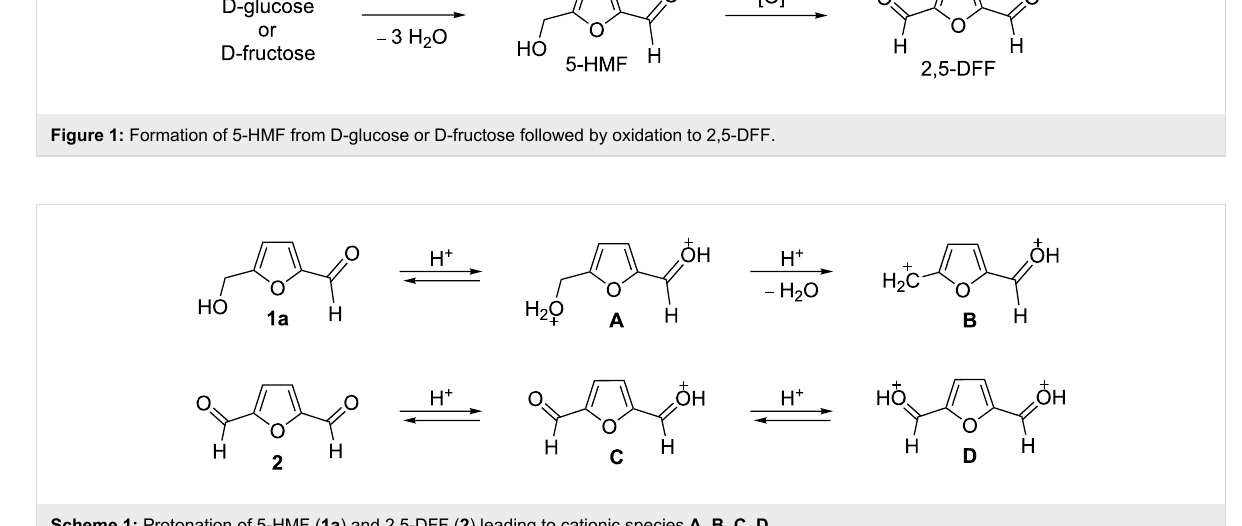
Scheme 1: Protonation of 5-HMF ( 1a ) and 2,5-DFF ( 2 ) leading to cationic species A , B , C , D